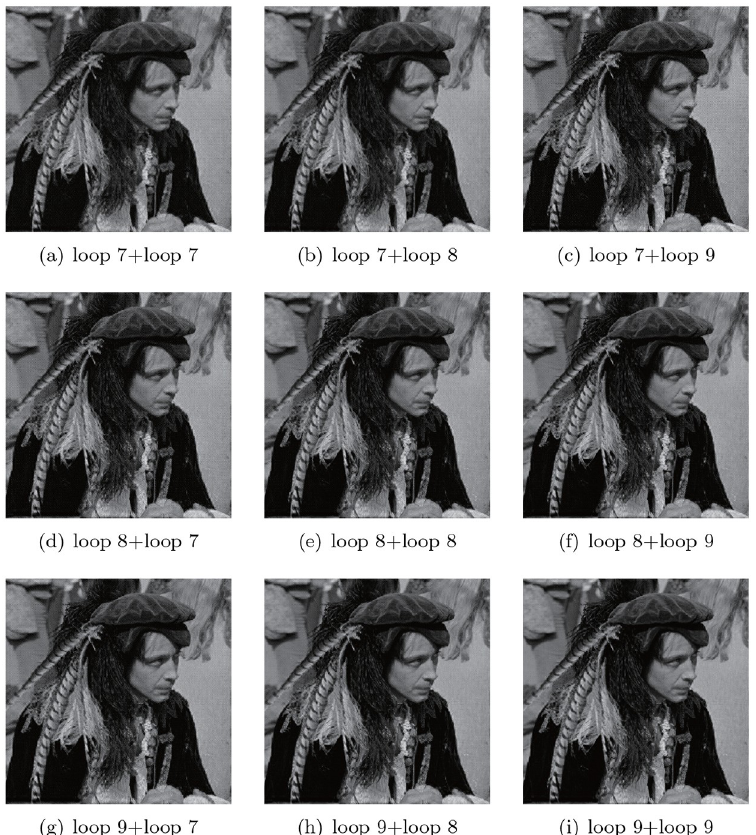
Fig 17. Visual performance of compression with different proportion of encoding level, for the both two kinds of coefficients, deeper encoding loop results in better reconstruction.